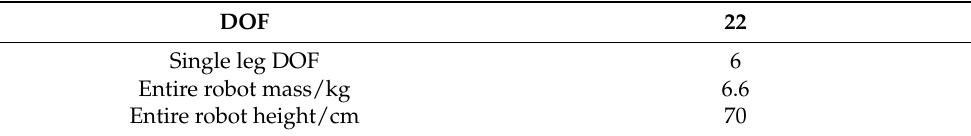
Figure 3. SolidWorks model of Roban and its steering gear distribution. Table 1. Specific parameters of Roban